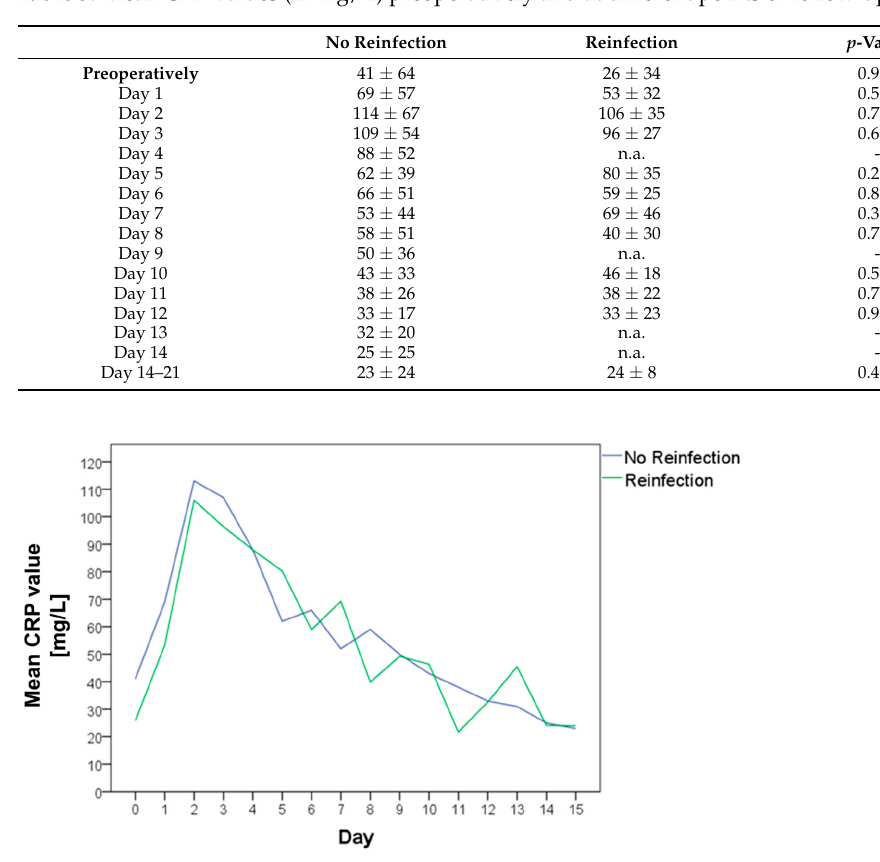
Figure 5. Mean C-reactive protein (CRP) value preoperatively and in the further clinical course of patients without reinfection (blue curve) and with reinfection (green curve).